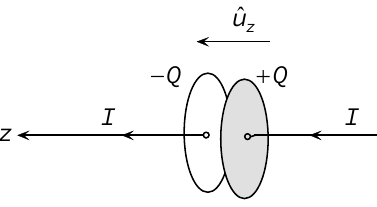
Figure 1: A current I charging a parallel-plate capacitor The capacitor is being charged at a rate dQ / dt=I ( t ), where +Q ( t ) is the charge on the right plate (as seen in the figure) at time t . If σ ( t ) =Q ( t )/ π a 2 =Q ( t )/ A is the surface charge density on the right plate, then the time derivative of σ is given